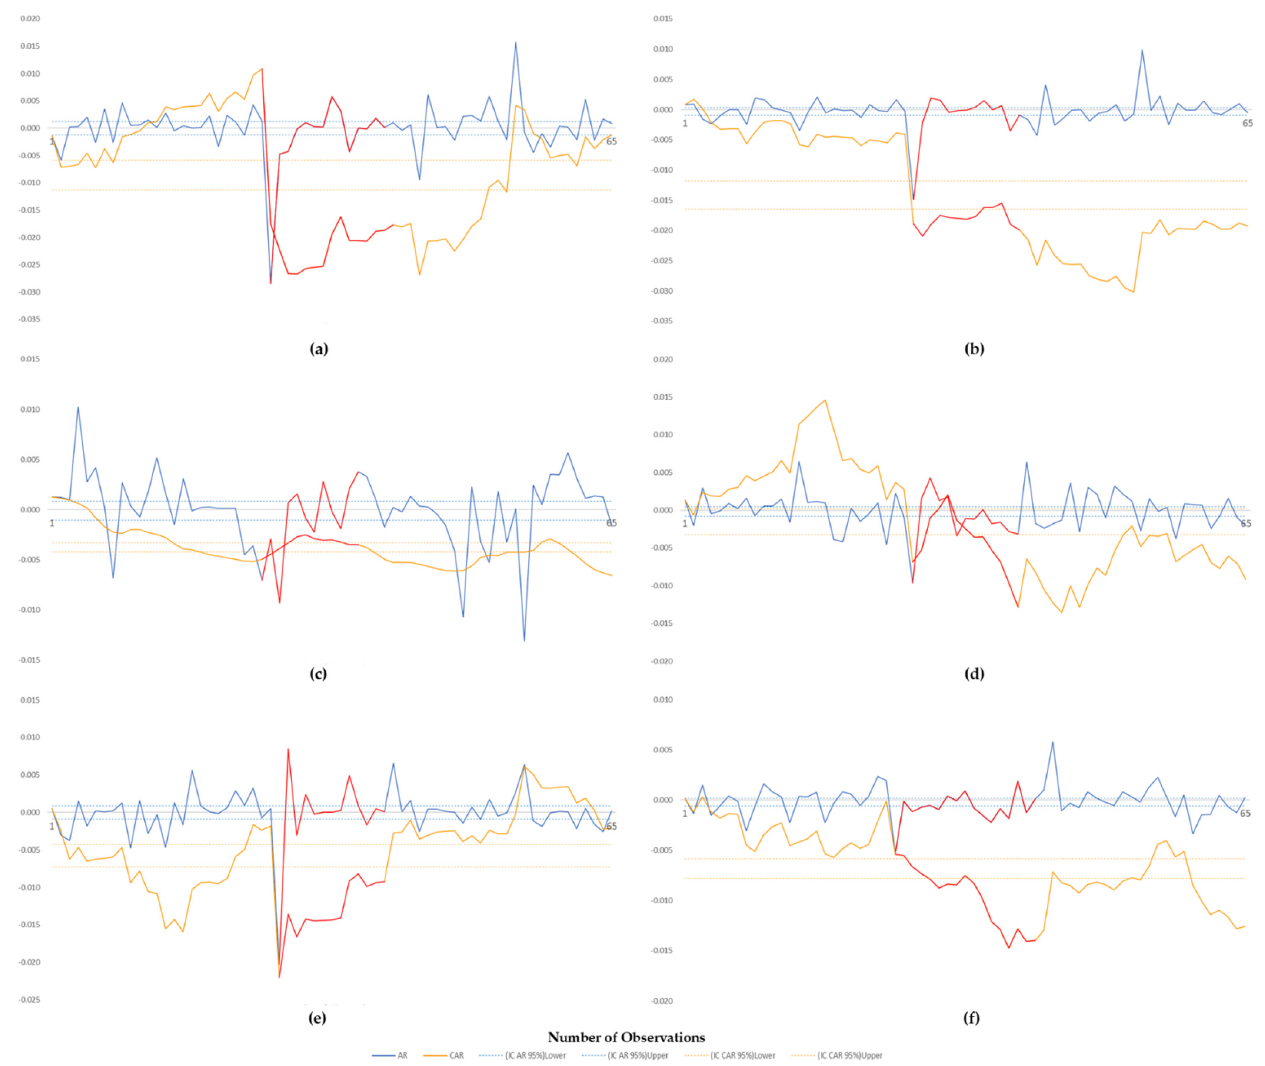
Figure 2. Abnormal returns (AR) and cumulative abnormal returns (CAR) on the event window for the following indices: ( a ) HSI, ( b ) JPXNK400, ( c ) KSE100, ( d ) BSESN, ( e ) CSI300, and ( f ) STI. If the aggregated abnormal return (AAR) and cumulative aggregated abnormal re-